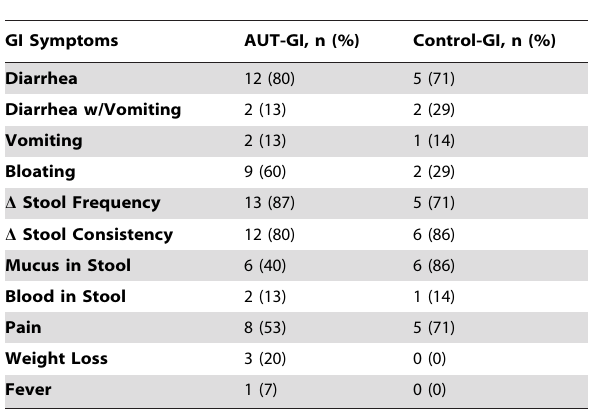
Table 2. Summary of patient GI